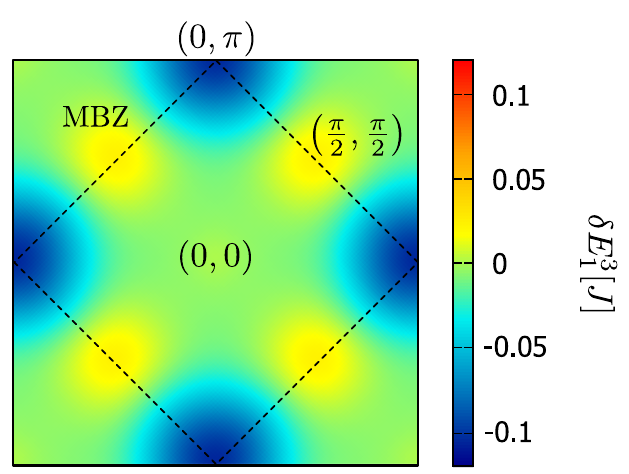
Figure 5: Shift of the dispersion given by (23) due to the flowing, i.e., renormalized, hybridiza- tion terms (cid:86) ± . Note that the shift is positive at wavevectors k = ( ± negative at k = ( ± π ,0 ) and k = ( 0, ± π )